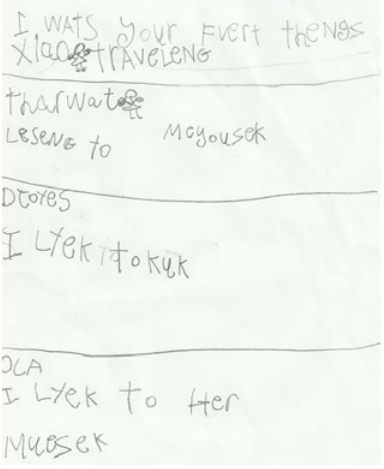
Figure 6: A five-year-old’s survey recording sheet asking staff members, “What is your favourite thing?”